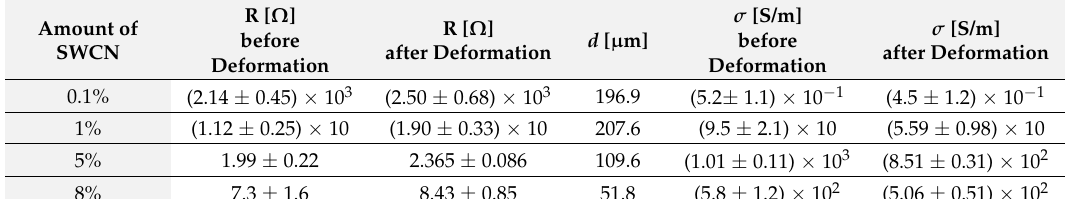
Table 1. Resistivity ( R ), conductivity ( σ ) and thickness ( d ) of L , D -PLA with selected content of SWCN.